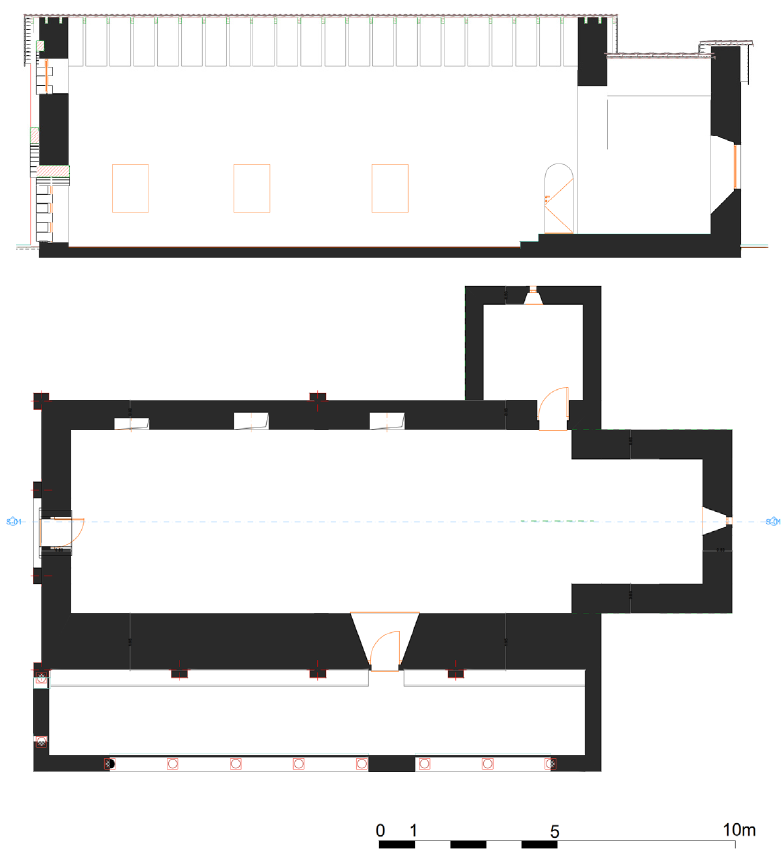
Figure 4. Plan layout and longitudinal section of St Paraskevi’s church in Cete. Provision courtesy of Arch. Arsim Murseli, UBT University, Pristina, Kosovo.